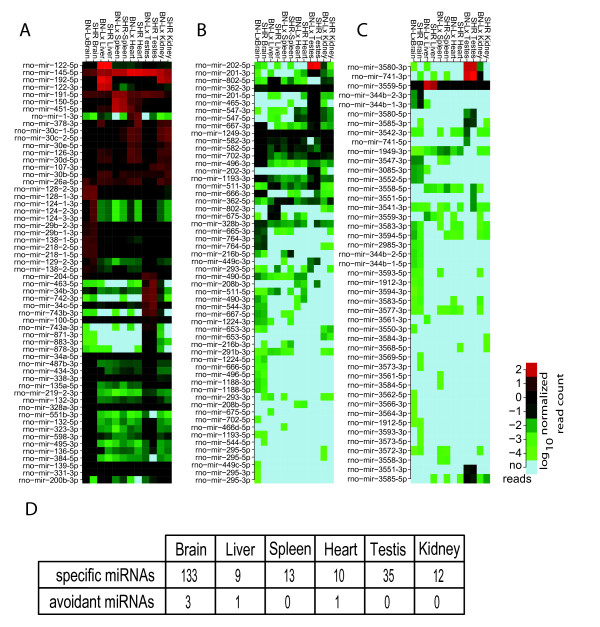
miRNA tissue expression profiles. A-C) Heatmaps show the expression (normalized, log10) of miRNAs. Each arm is represented separately, as are miRNAs in the reverse orientation (if applicable). In (A), the first 10% of the heatmap is shown. miRNAs derived from loci that are homologous to miRBase human or mouse miRNA loci are shown in (B). Completely novel miRNAs are shown in (C). The legend is valid for the 3 heatmaps. D) Each tissue expresses a distinct set of miRNAs (tissue specific miRNAs). Also, some miRNAs are specifically not expressed in certain tissues (tissue avoidant miRNAs). miRNAs are specific in both replicates and the arbitrary, but strict, cutoff of 5-fold difference in expression was applied to determine specificity and avoidance.